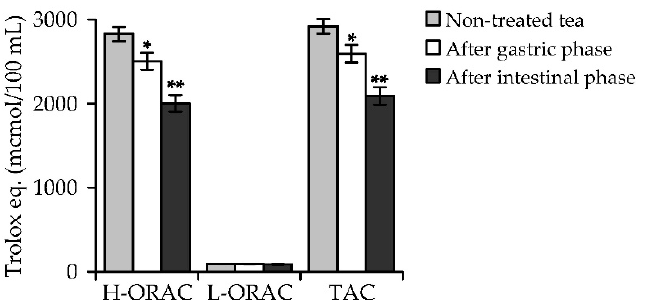
Figure 6. Capacity of hydrophilic (H-ORAC) and lipophilic (L-ORAC) antioxidants and total antioxidant capacity (TAC; as Trolox equivalents, µ mol per 100 mL) of A. frigida herbal tea before and after in vitro treatment with simulated gastric and intestinal media. Results show mean ± SEM of four